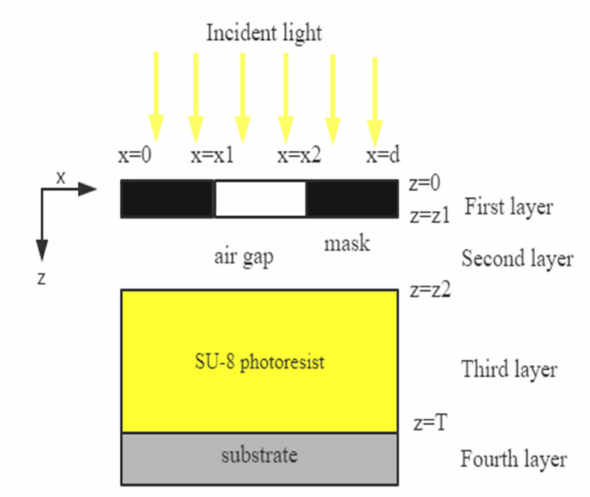
Figure 4. The two-dimensional schematic of the waveguide